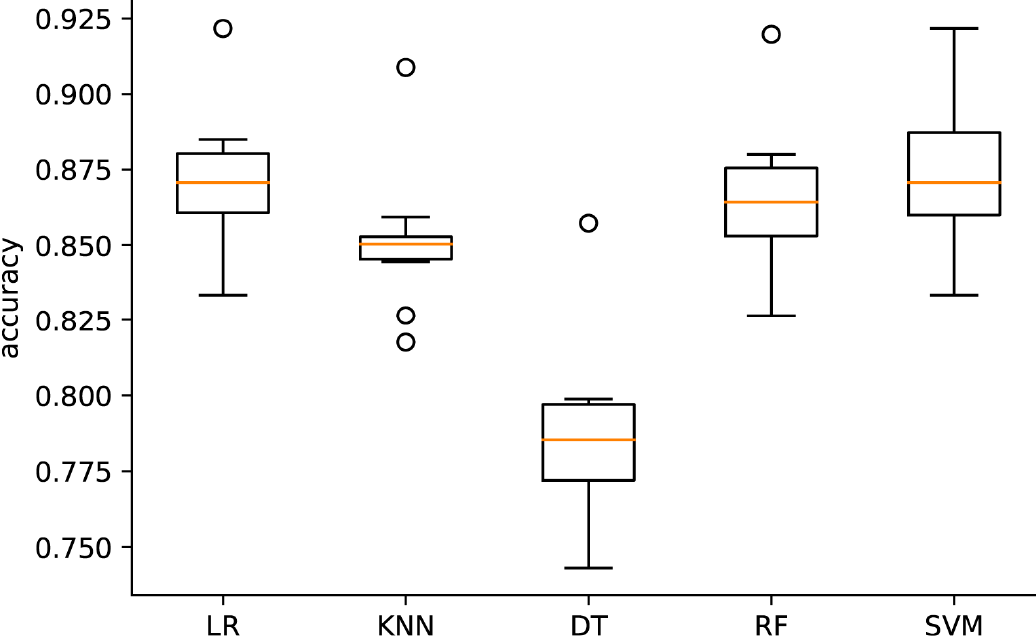
Figure 1. Box plot of the accuracy scores across each algorithm for normalized data. LR—logistic regression; KNN—k-nearest neighbor; DT—decision trees; RF—random forests; SVM—support vector machines.